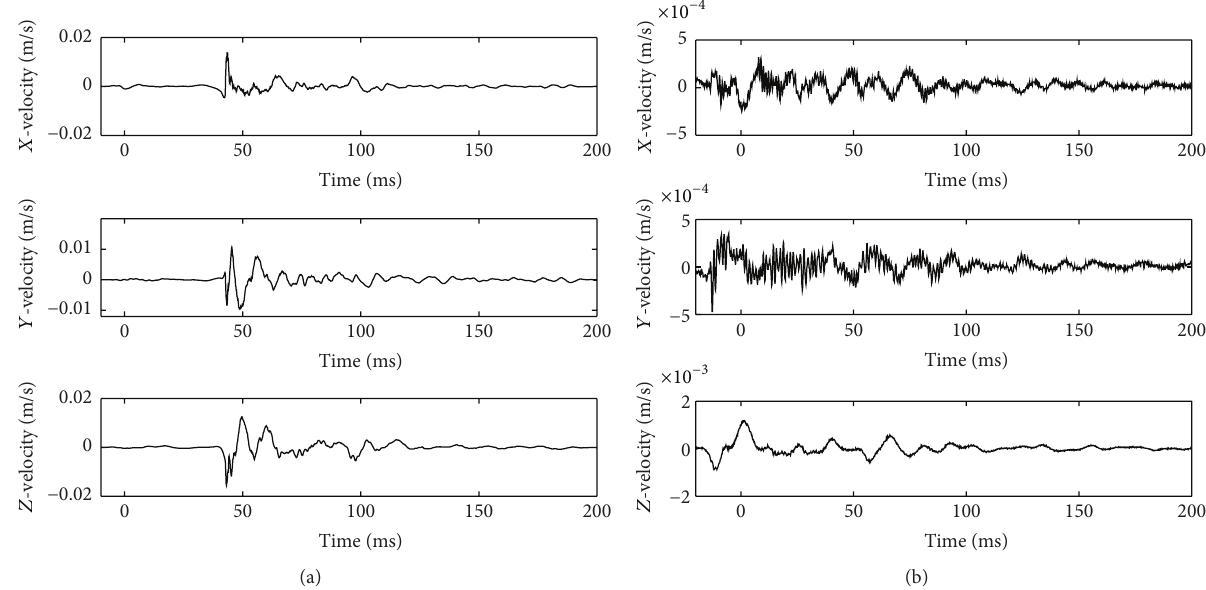
curve0.51.52.5 PP